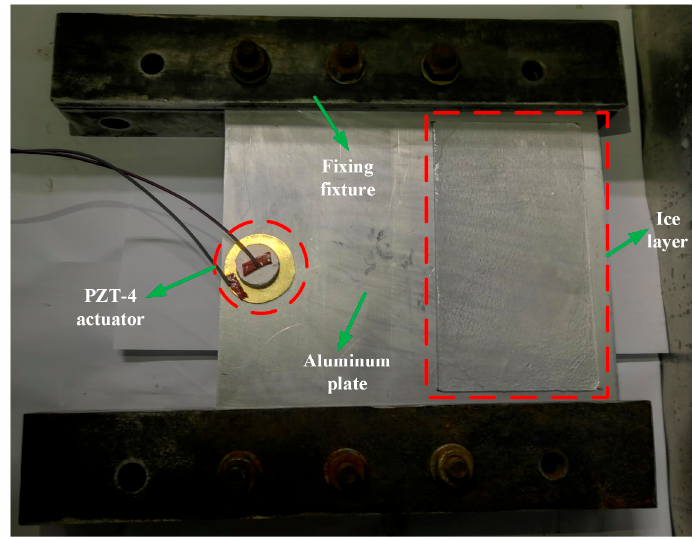
Figure 6. Experimental setup for deicing experiments.